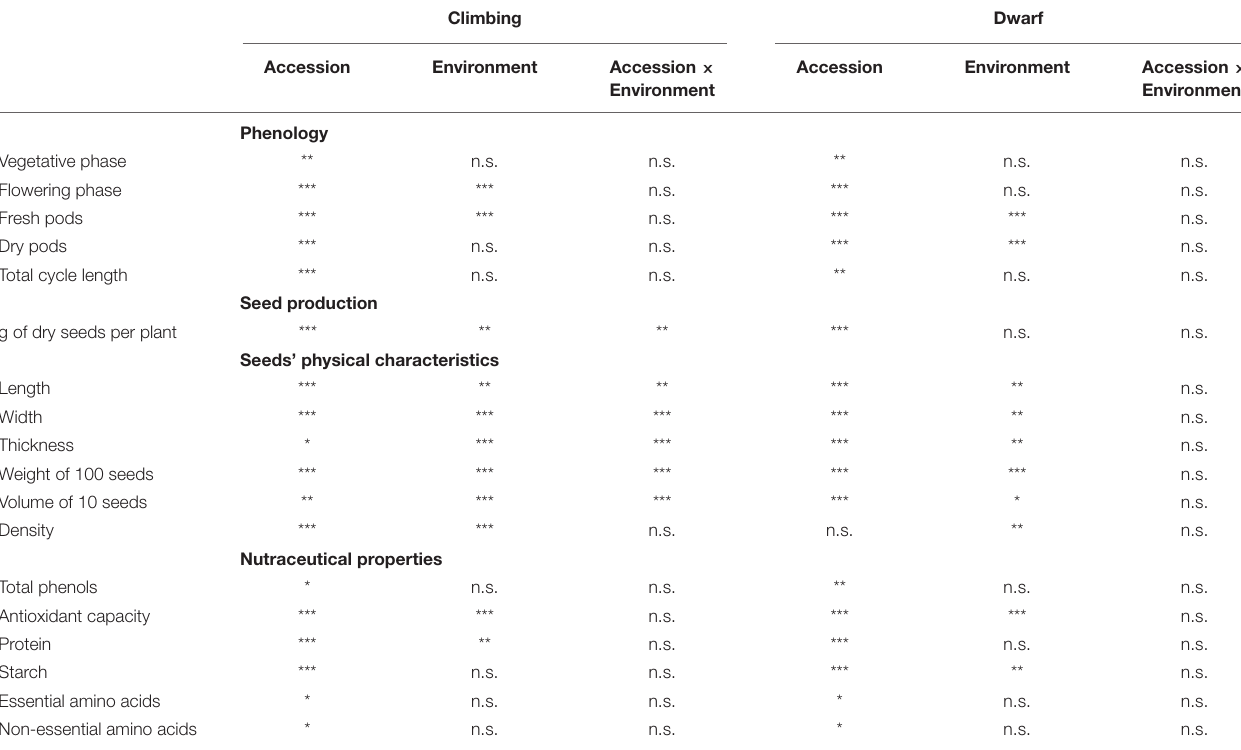
TABLE 7 | Analysis of variance (ANOVA) table with the effects of accession, environment, and the interaction of accession and environment on climbing and dwarf accessions phenology, seed production, seeds’ physical characteristics, and seeds’ nutraceutical properties. Climbing